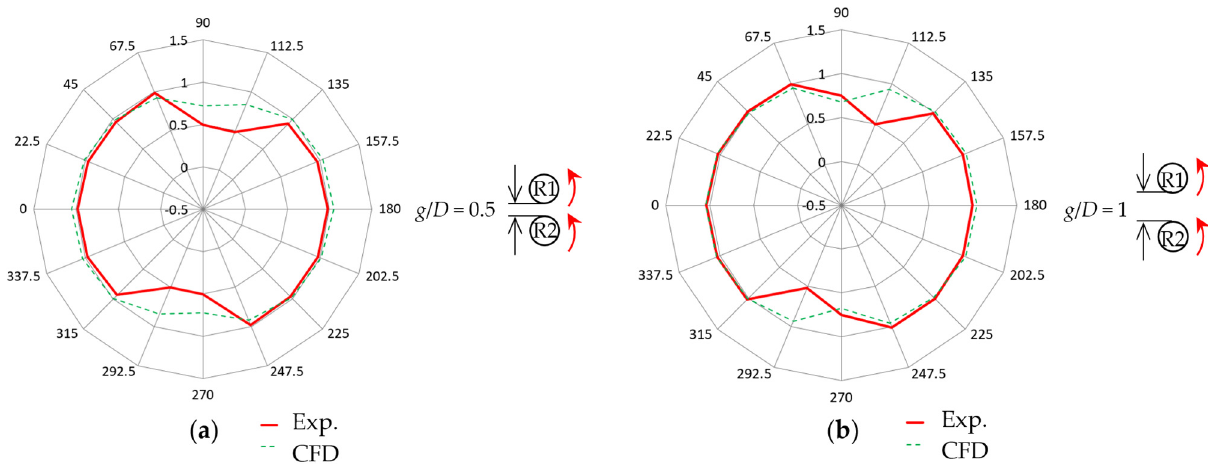
Figure 15. Comparison between the experimental and CFD results on 16 ‐ wind ‐ direction depend ‐ ence of average normalized rotational speed in a pair of VAWT models in CO configuration at V = 14 m/s: ( a ) g / D = 0.5; ( b ) g / D = 1.